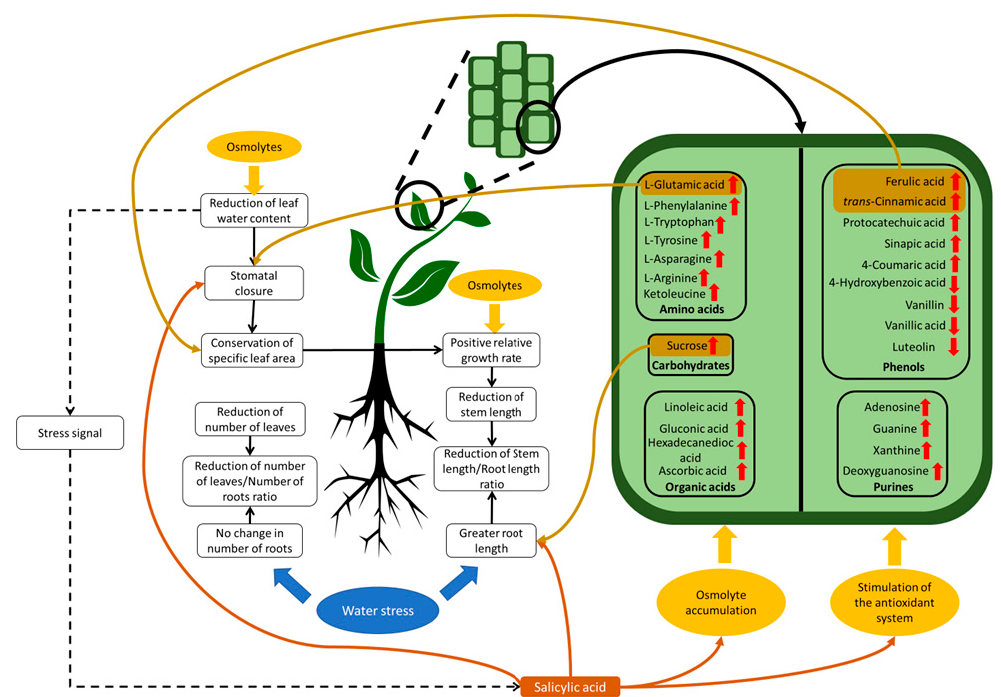
Figure 7. Morphological and physio-chemical responses of vanilla hybrids exposed to PEG-induced water stress. Water-stress-tolerant plants exhibit changes in morphology such as root elongation and reduction in leaf production and size, which increase water uptake. Additionally, stomatal closure is induced. Primary and secondary metabolism is modified in order to promote the accumulation of metabolites that act as osmolytes and antioxidants. Red arrows indicate an increase in the content of certain metabolites, while purple arrows indicate a decrease. Figure includes data from the present study and from the literature [11,14,16–20,40,41,45–49,57–62,73–75]. Overall, both hybrids had multiple responses to tolerate PEG-induced water